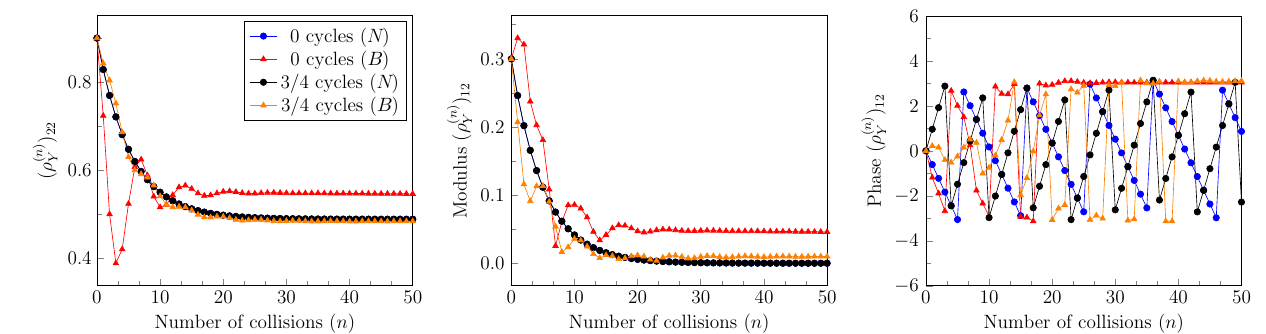
FIG. 4. Effect of free evolution between collisions on the populations (left panel), modulus and phase of coherences (middle and right panel, respectively) for a two-level system colliding with narrow ( N ) and broad ( B ) Gaussian wave packets. The system evolves freely for 0 or 3 / 4 cycles between each collision. The initial state is (ρ Y ) ( 0 ) parameters are (cid:8) Y = m = 1, p 0 = 6.3, and σ/( m (cid:8) Y / 2 p 0 ) = 0.12 for narrow wave packets and σ/( m (cid:8) Y / 2 p 0 ) = 12 for broad wave